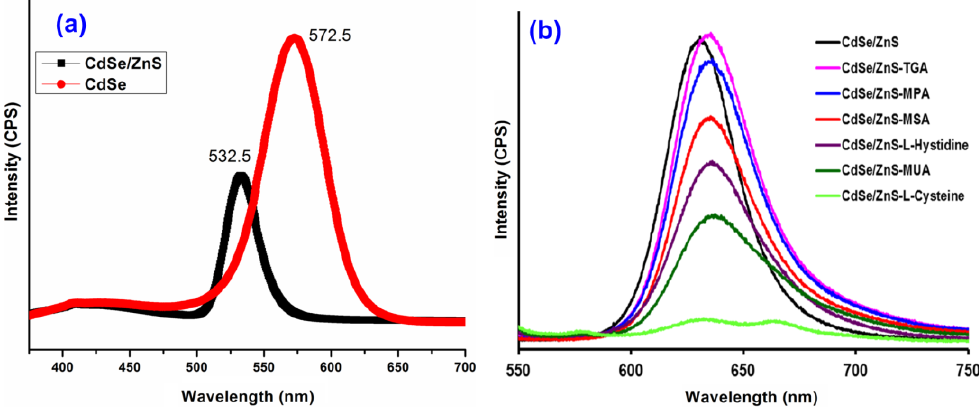
Figure 3. ( a ) Fluorescence intensity peaks for CdSe and CdSe/ZnS QDs when recorded using PL measurements and ( b ) fluorescence for the CdSe/ZnS QDs with different surface ligands (TGA, MPA, MSA, L -Histidine, MUA, and L -Cysteine) using spectrofluorescence measurement.